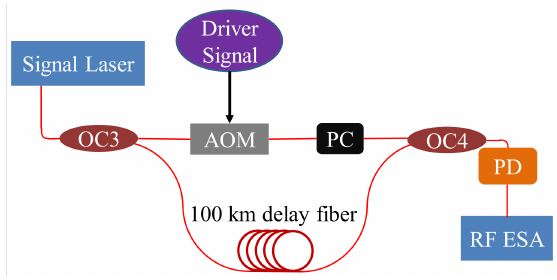
Figure 6. Schematic of the